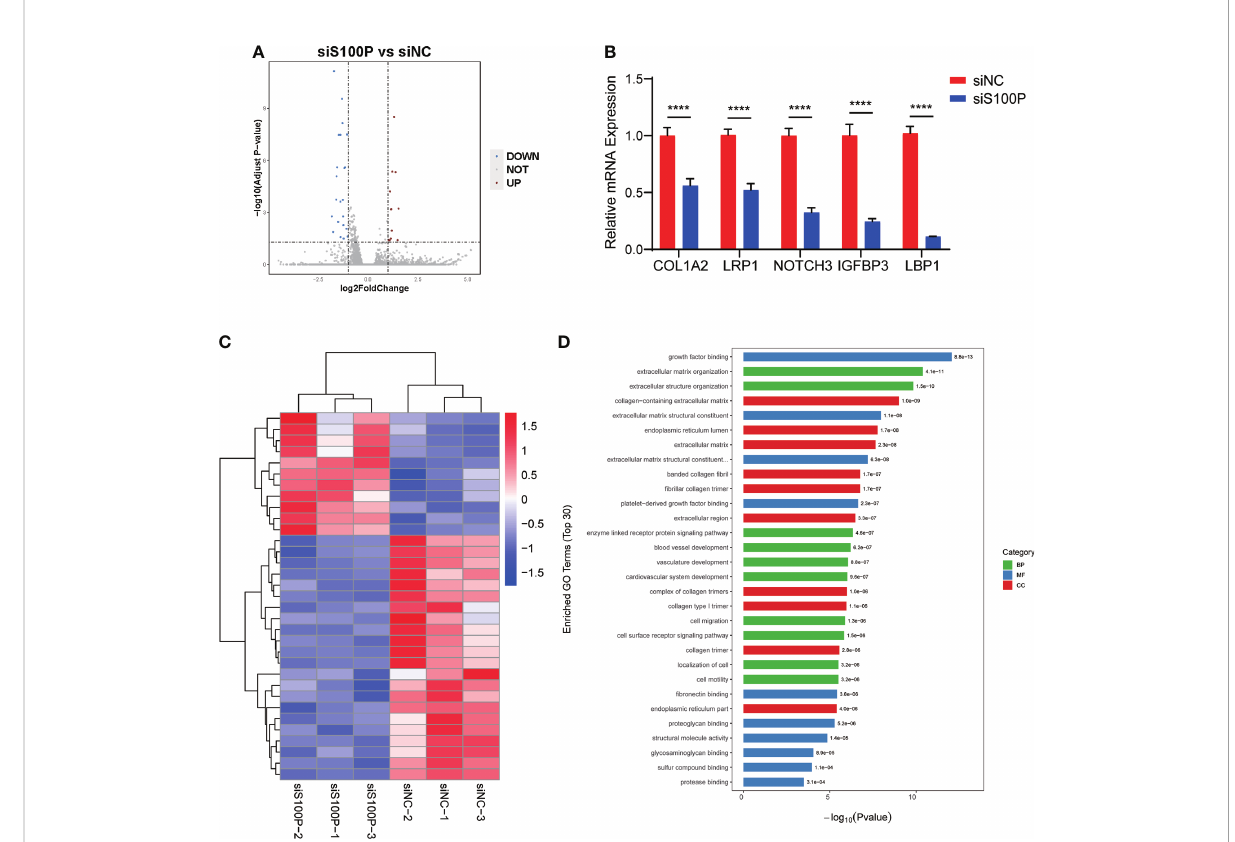
FIGURE 7 Transcriptional pro fi ling of ST(2D)-TS CT cells with S100P interference. (A) Volcano plots of differentially expressed genes after S100P knockdown. The red dots indicate upregulated genes, and the blue dots indicate downregulated genes. (B) RT-qPCR analysis of some downregulated and upregulated genes from the RNA-seq data analysis. Data are presented as the mean values ± SEMs. **** p <0.0001. (C) Heatmap of all the upregulated- and downregulated genes between the two groups. (D) Enriched biological process, molecular function, and cellular component terms of the downregulated differentially expressed genes in siS100P ST(2D)-TS CT cells as assessed by GO